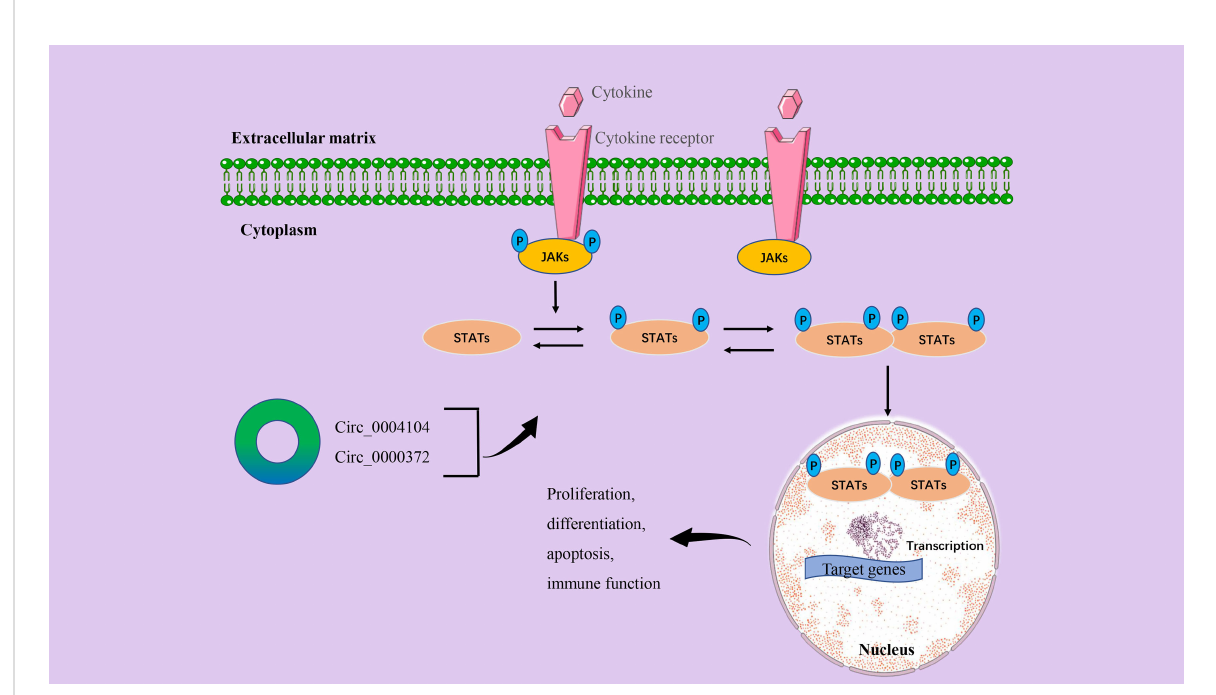
FIGURE 5 The circRNA/JAK/STAT signaling axis in CRC. The binding of the cytokine to the receptor induces receptor dimers and initiates signal transduction. After JAKs are activated and phosphorylated, STATs proteins are recruited to the phosphorylated tyrosine site. STATs are also then activated and phosphorylated. Normally, STATs reside in the cytoplasm and form phosphorylated dimers when activated by upstream signals. STAT-STAT dimers are transferred from the cytoplasm to the nucleus and regulate the transcription of target genes. Finally, it affects the proliferation, differentiation, invasion, in fl ammation, and immune function of cancer